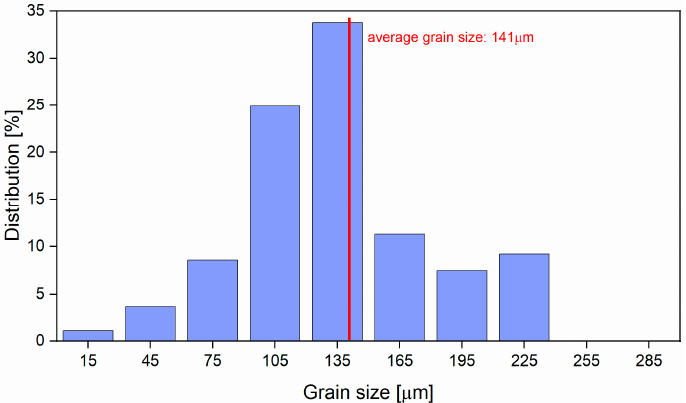
Figure 4. Microstructure of the AR TNTZ alloy.